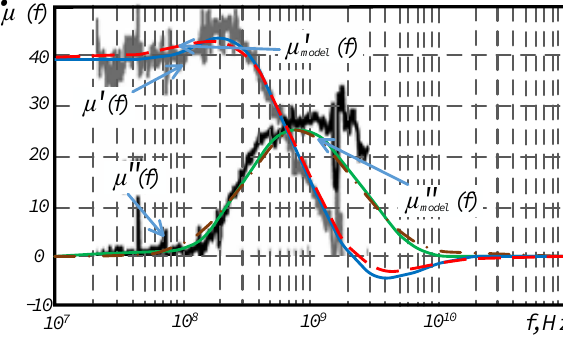
Fig. 6. KKR application to CIP spectrum of Ni 0.2 Zn 0.3 Fe 2 O 4 ferrite